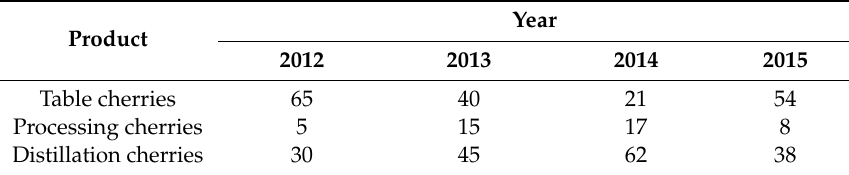
Table 1. Proportion (in %) of the Swiss sweet cherry production assigned to table cherries for fresh consumption, cherries for processing and cherries for distillation in 2012–2015 (Source: Swiss Farmers’ Union, www.sbv-usp.ch).